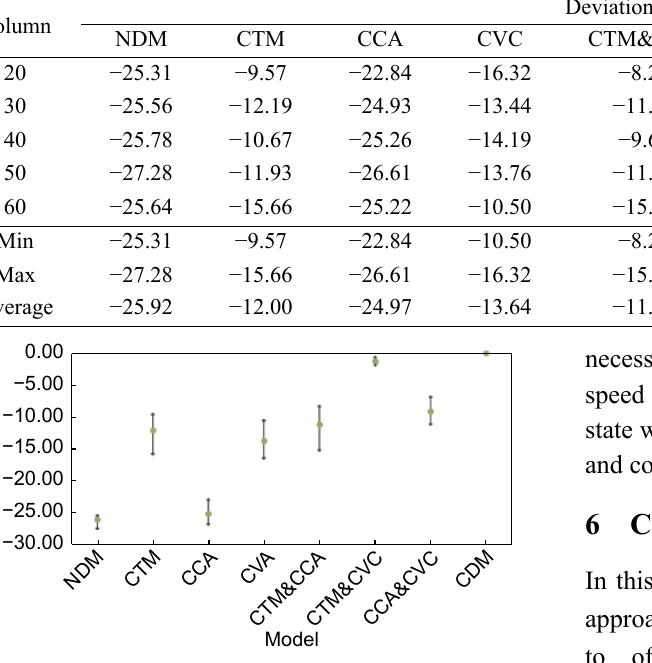
Fig. 14 Makespan deviation in different column numbers of different